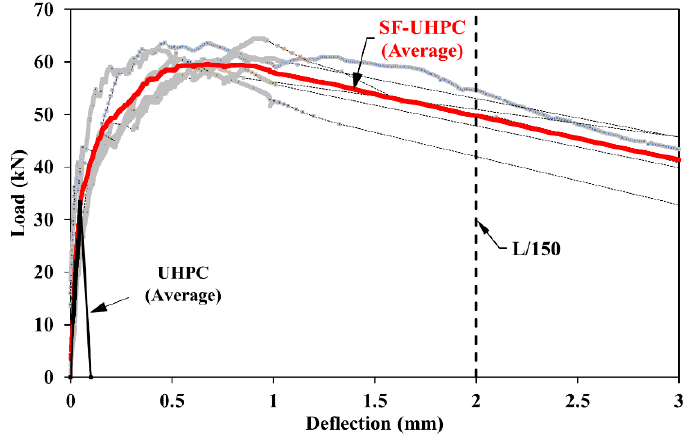
Figure 5. Load-deflection curves of prismatic specimens with and without steel fiber.